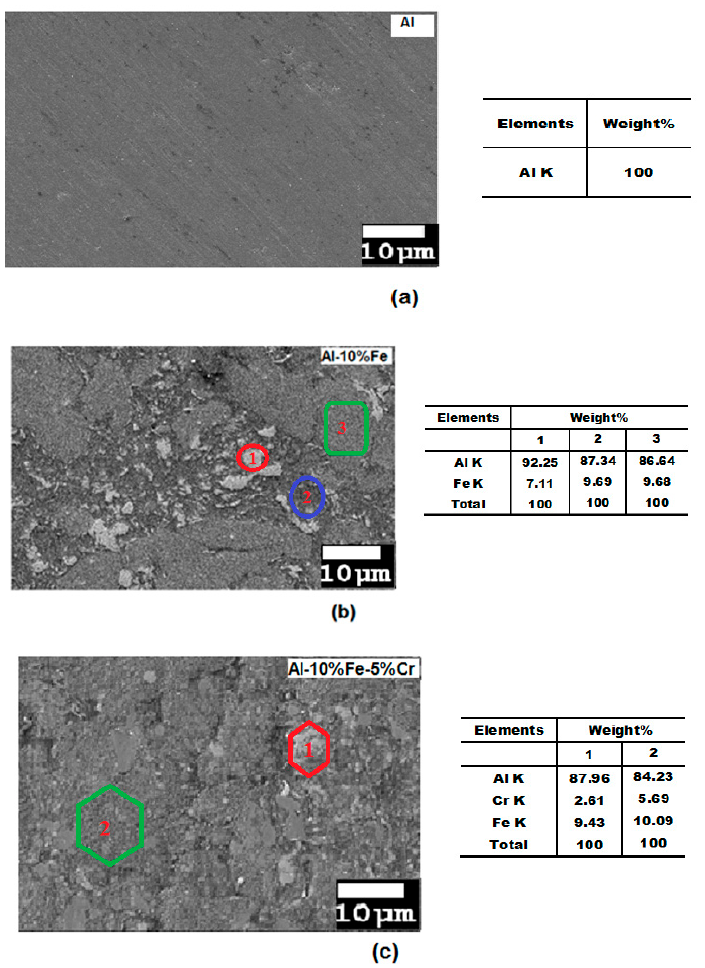
Figure 1. SEM micrograph and EDX profile analysis obtained on the nanocrystalline Al ( a ), Al ‐ 10% Fe ( b ) and Al ‐ 10% Fe ‐ 5% Cr ( c ) alloy after sintering.